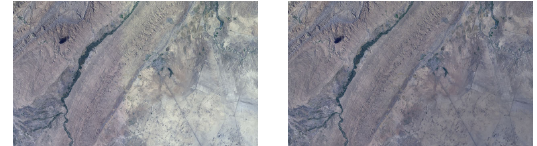
Figure 1. An example illustrating that blending can’t obviously eliminate the tonal difference alone. The left mosaicked image was obtained directly by a multi-band blending technique. The right mosaicked image was generated by our proposed tonal correction followed by a multi-band blending technique. which assume the color relation between images can be described by a transform: ^ I = f ( I ) , where f stands for any transformation equation for a color vector I . (Reinhard et al., n.d.) were pioneers in establishing the concept of color transfer, with an approach to modify the color distribution of the original image based on the global color statistics of an example image in the decorrelated color space l(cid:11)(cid:12) . Their work has been widely used as the baseline approach by other approaches. To operate color in the